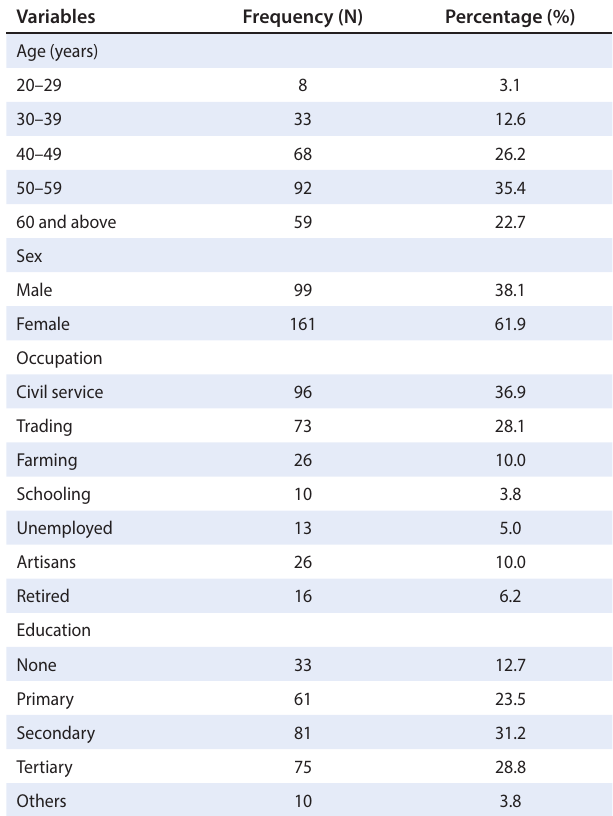
Table 1: Socio-demographic characteristics of study participants (n =